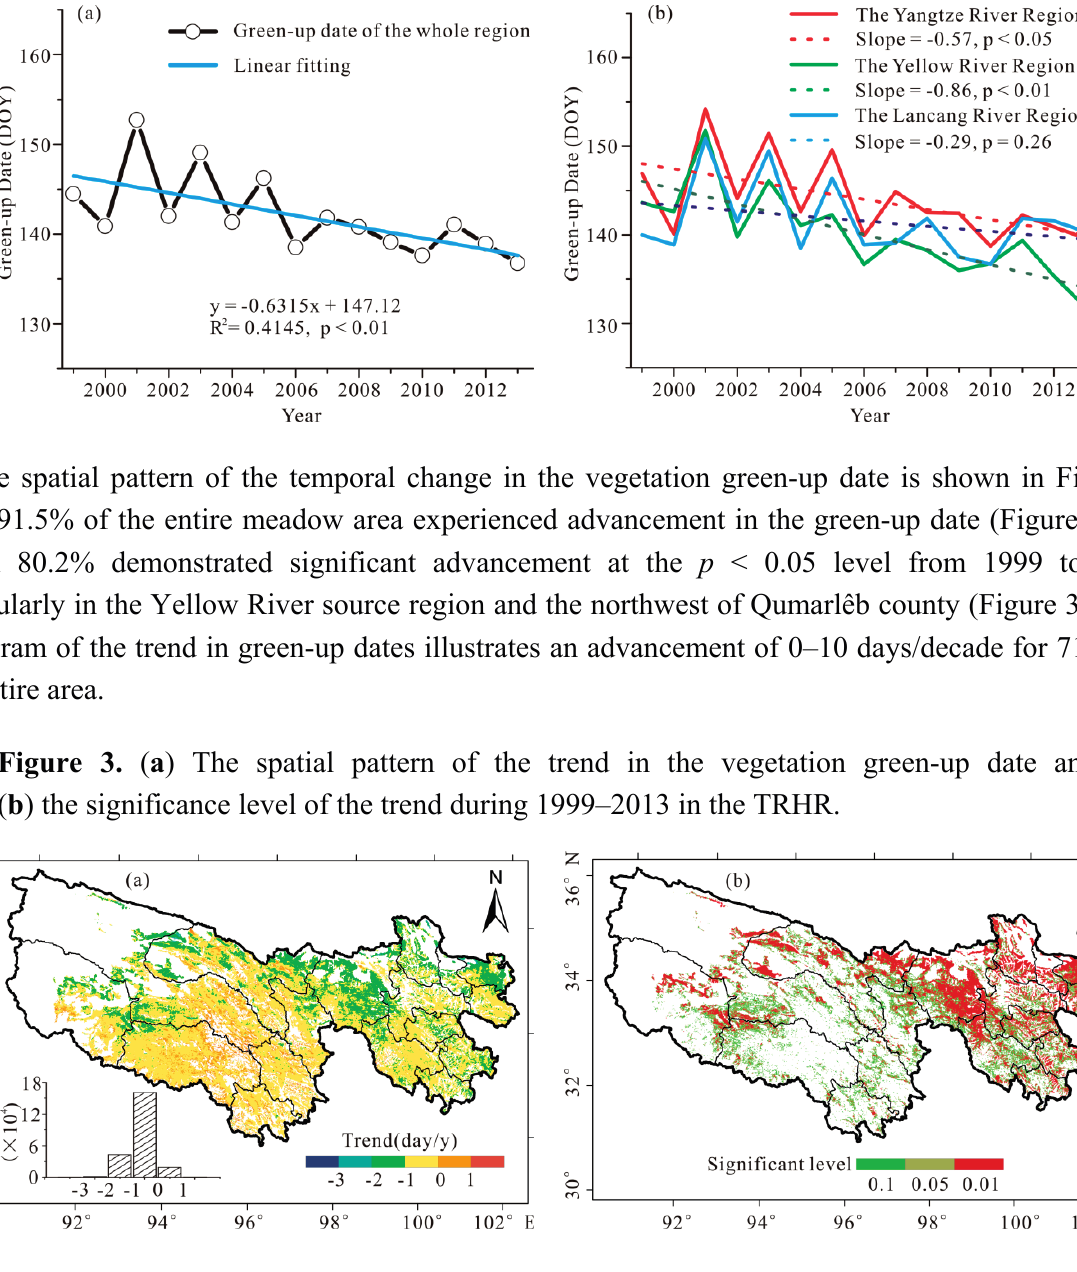
Figure 2. ( a ) Interannual change in the vegetation green-up date for the entire study area and ( b ) for individual river sources during 1999–2013.